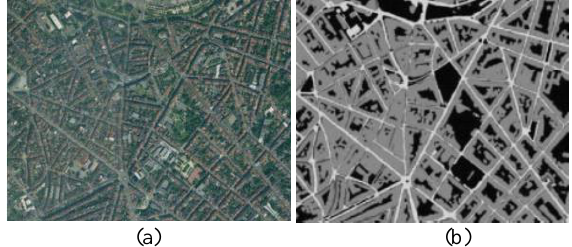
Figure 3. Extraction of road network. (a) Original image. (b) Extracted road